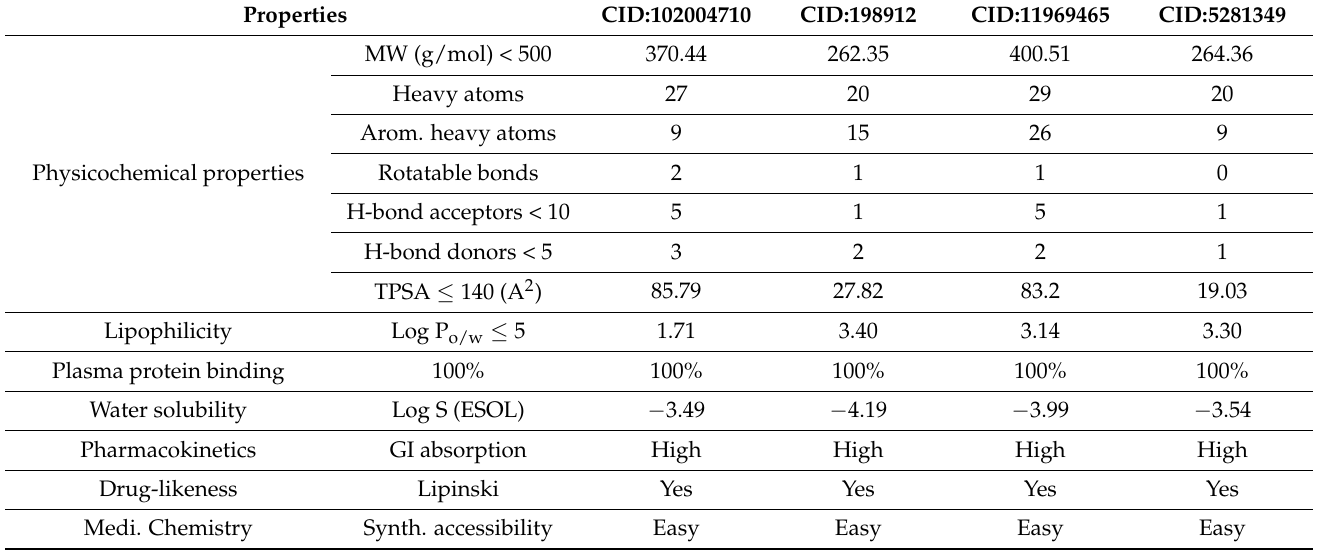
Table 2. List of pharmacokinetics properties includes physicochemical properties, lipophilicity, plasma protein binding, water-solubility, drug-likeness, and medicinal chemistry of the four selected compounds: medi. chemistry = medicinal chemistry; TPSA = topological polar surface